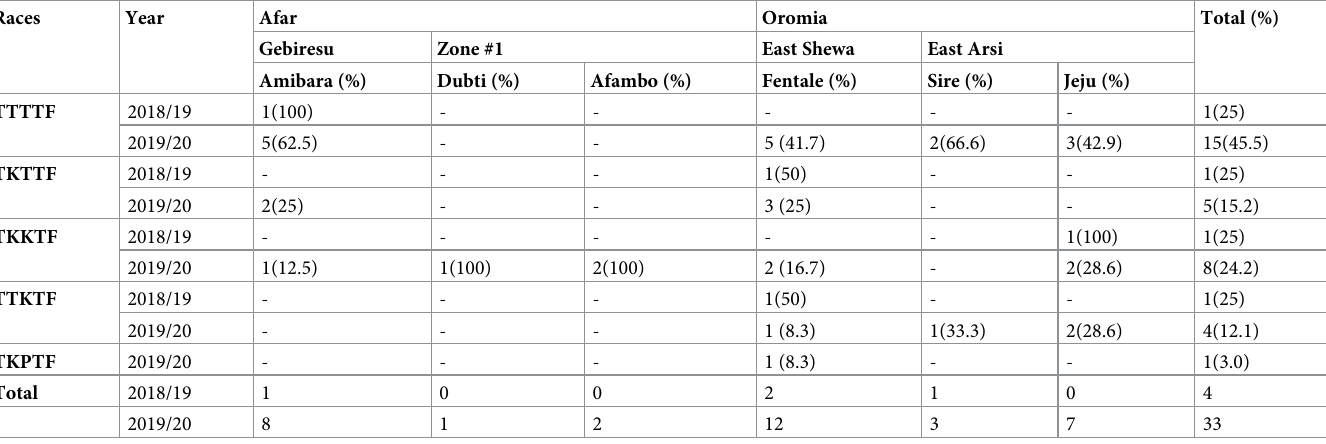
Fig 6. The Stem rust diseases progress in Awash River Basin over the six years (2014/15-2019/20) “reprinted from [ref] under a CC BY 4.0 license, with permission from [PLOS ONE], original copyright [2021]”. Sire districts, respectively. While in the Afar region, 100%, 33.33%, and 25% were viable in Amibara, Afamboand Asaita, and Dubti districts, respectively Table 4. Urediniospores, col- lected from each field were suspended in lightweight mineral oil called Soltrol-170 and Table 4. Distribution and frequency of P.gt. races in Awash River Basin irrigated wheat in 2018/19 and 2019/20 for the irrigated wheat cropping season.